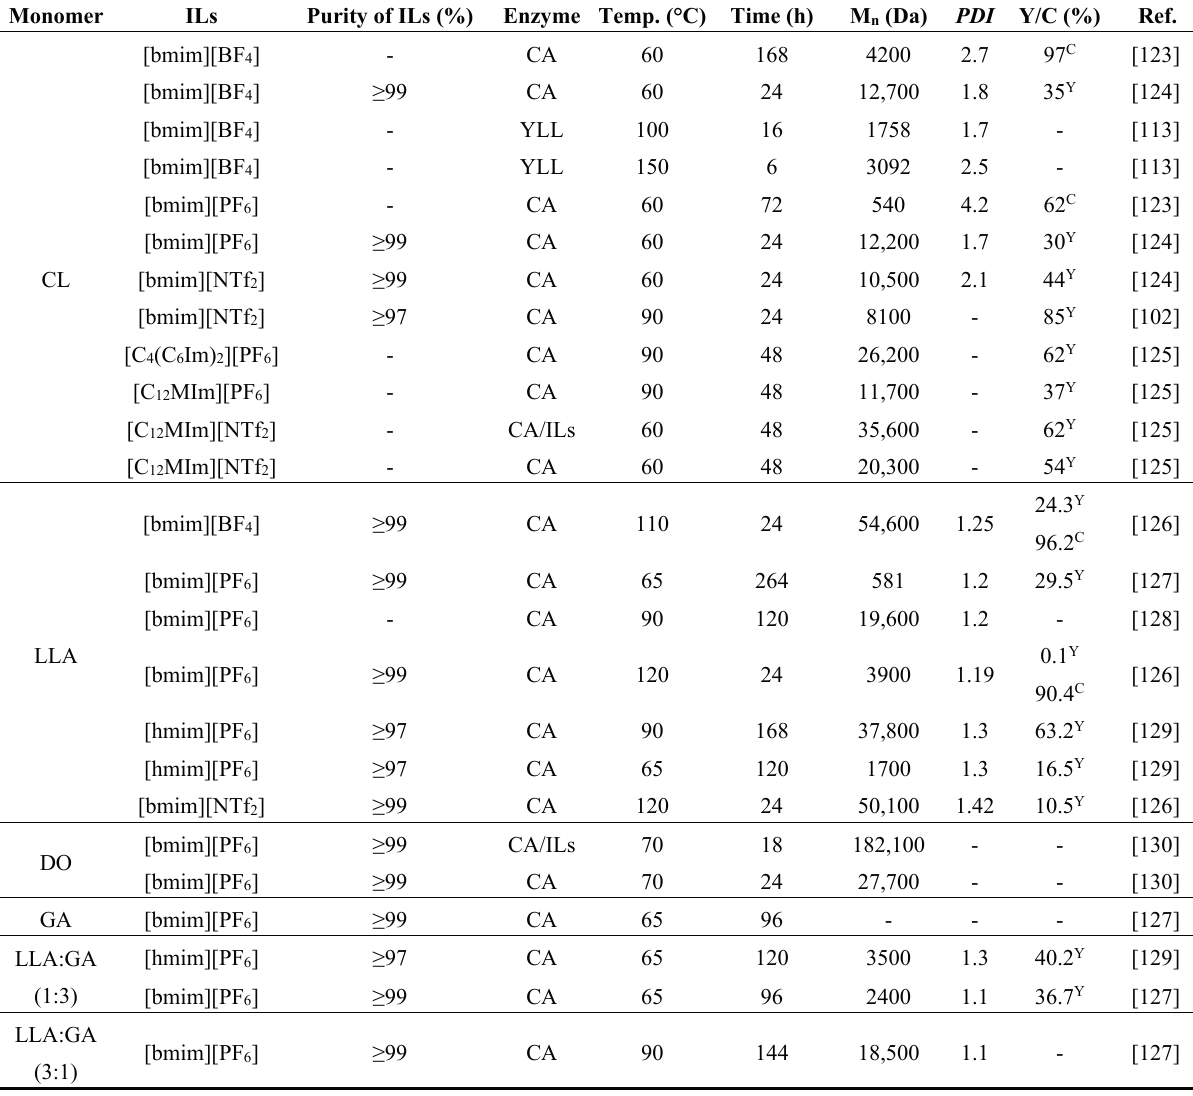
Table 5. Ring opening enzymatic polymerization and copolymerization of cyclic esters in ionic